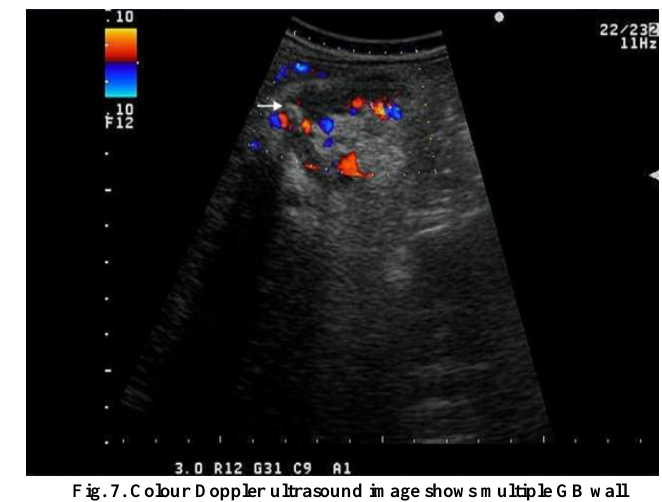
Fig. 7. Colour Doppler ultrasound image shows multiple GB wall varices in a patient having chronic portal vein thrombosis. Solitary GB calculus is also seen( →